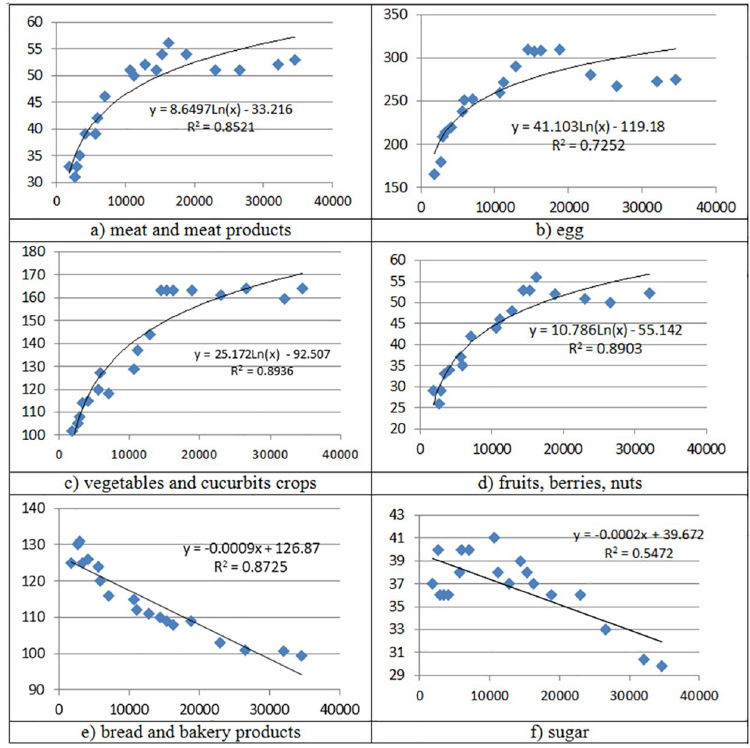
Fig 3. The equation of the relationship between the consumption of certain foods and the income level of the population. Source: calculated by the authors.